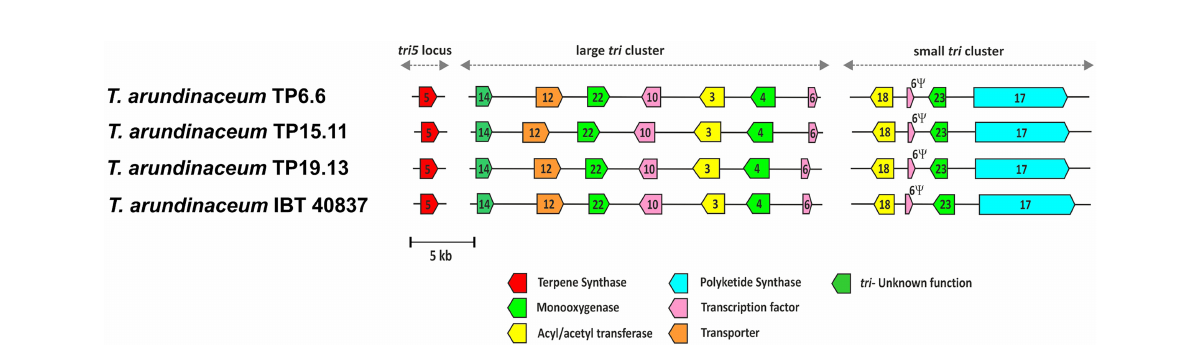
FIGURE 5 Trichothecene biosynthetic genes ( tri ) in the genomes of the three Trichoderma strains isolated in the current study. Trichoderma arundinaceum IBT40837 was included for comparative purposes. Numbers inside arrows indicate the tri gene illustrated, e.g., 5 corresponds to tri5 gene. Different arrow colors indicate different gene functions as shown at the bottom of the fi gure. Y corresponds to a tri6